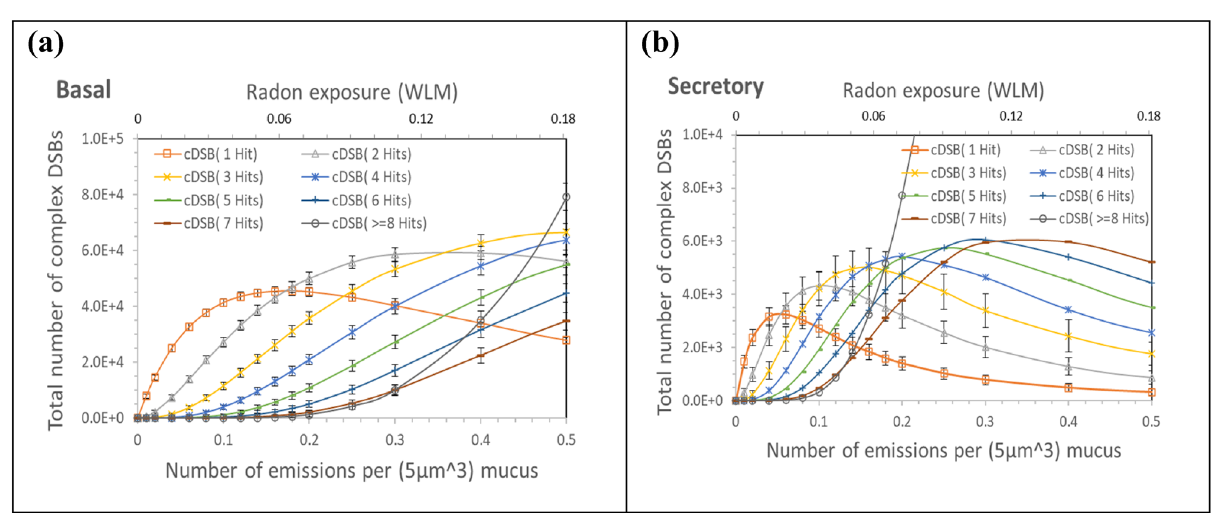
Figure 11. Total numbers of complex DSBs generated in all nuclei of the lung segment via different numbers of hits by alpha particles due to varied levels of radon exposure (up to 0.18 WLM): ( a ) basal and ( b ) secretory cells. The numbers of alpha emissions from a 5 µm 3 mucus correspond to the levels of radon exposure, respectively. Each bar indicates one standard deviation of estimated mean value. Statistical uncertainty for secretory cells is high due to the lowest amount in the bronchial tissue. Estimated mean values of complex DSBs by more than four hits may lack statistical